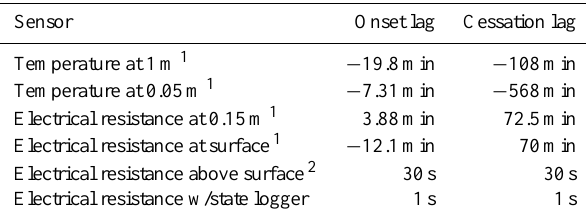
Table 1. Lag times for sensor